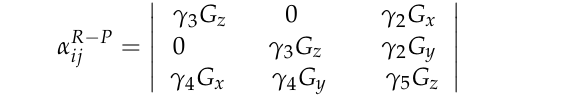
(cid:110) (cid:111) E , I , C y group G = , where the , C z , C z + 2 2 4 4 h